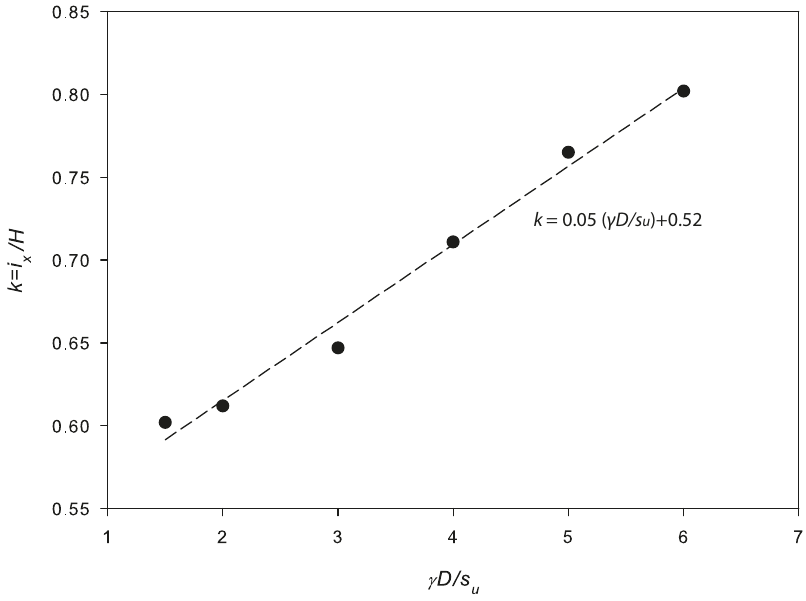
Figure 20. Relationship between k and γ D/S u .